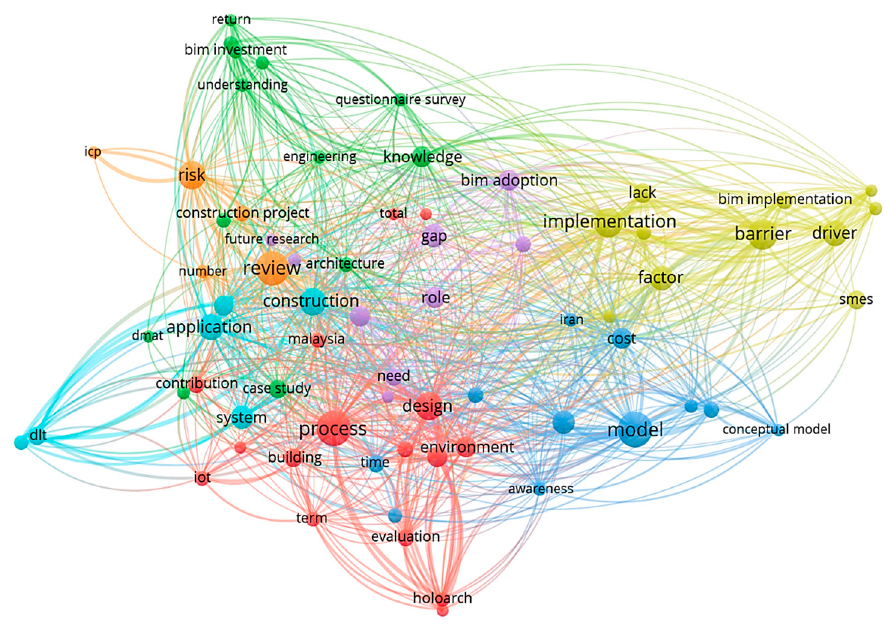
Figure 3. Co-occurrence map on BIM innovation in developing countries.